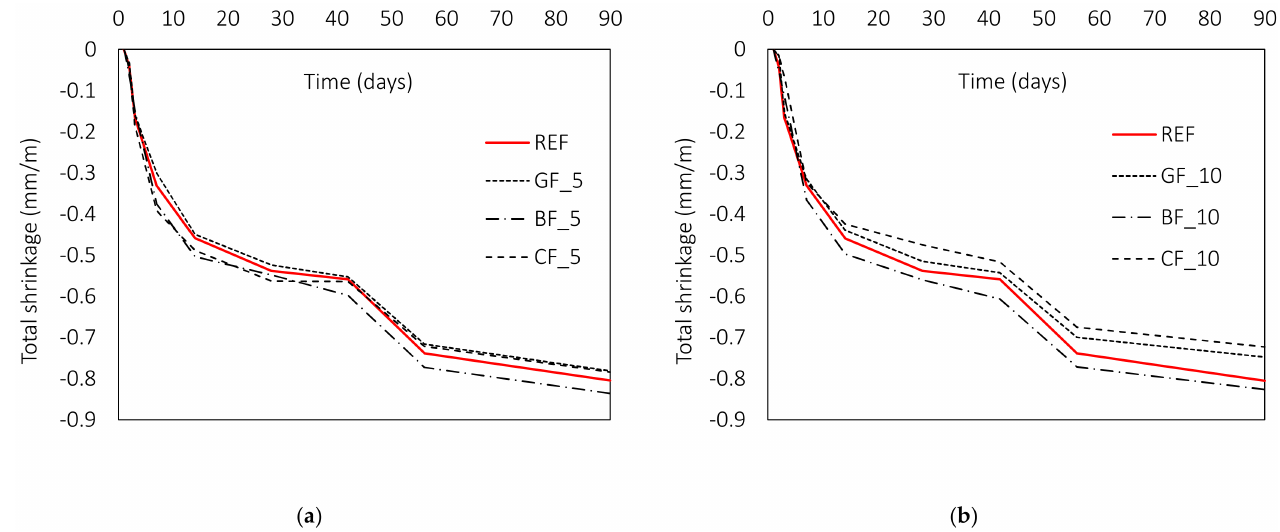
Figure 9. Influence of fibre type and length on total shrinkage of fibre-reinforced mortars: ( a ) l f = 5 mm; ( b ) l f = 10 mm.